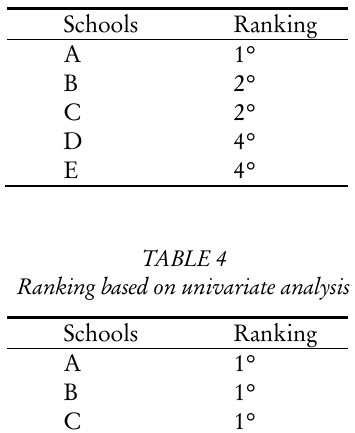
NPC-Global ranking based on the three variables: Improvement, Courtesy and